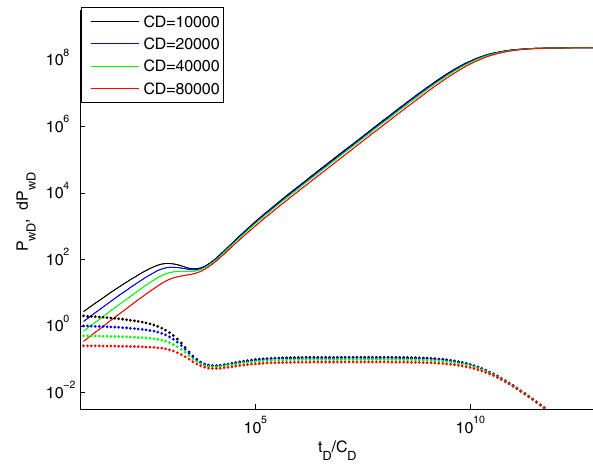
Fig. 4 Effect of C D on the characteristic